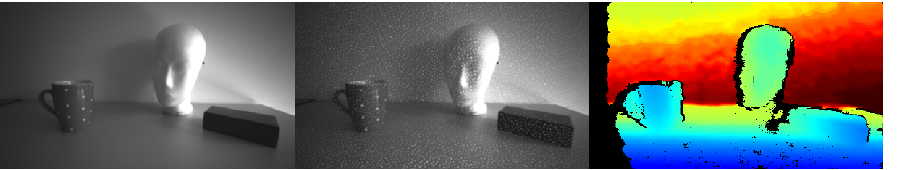
Figure 3. Image sequence as seen by the filtered camera outputs. Left , image without emitter projector, middle , image with emitter projector pattern (white spots) and right , depth